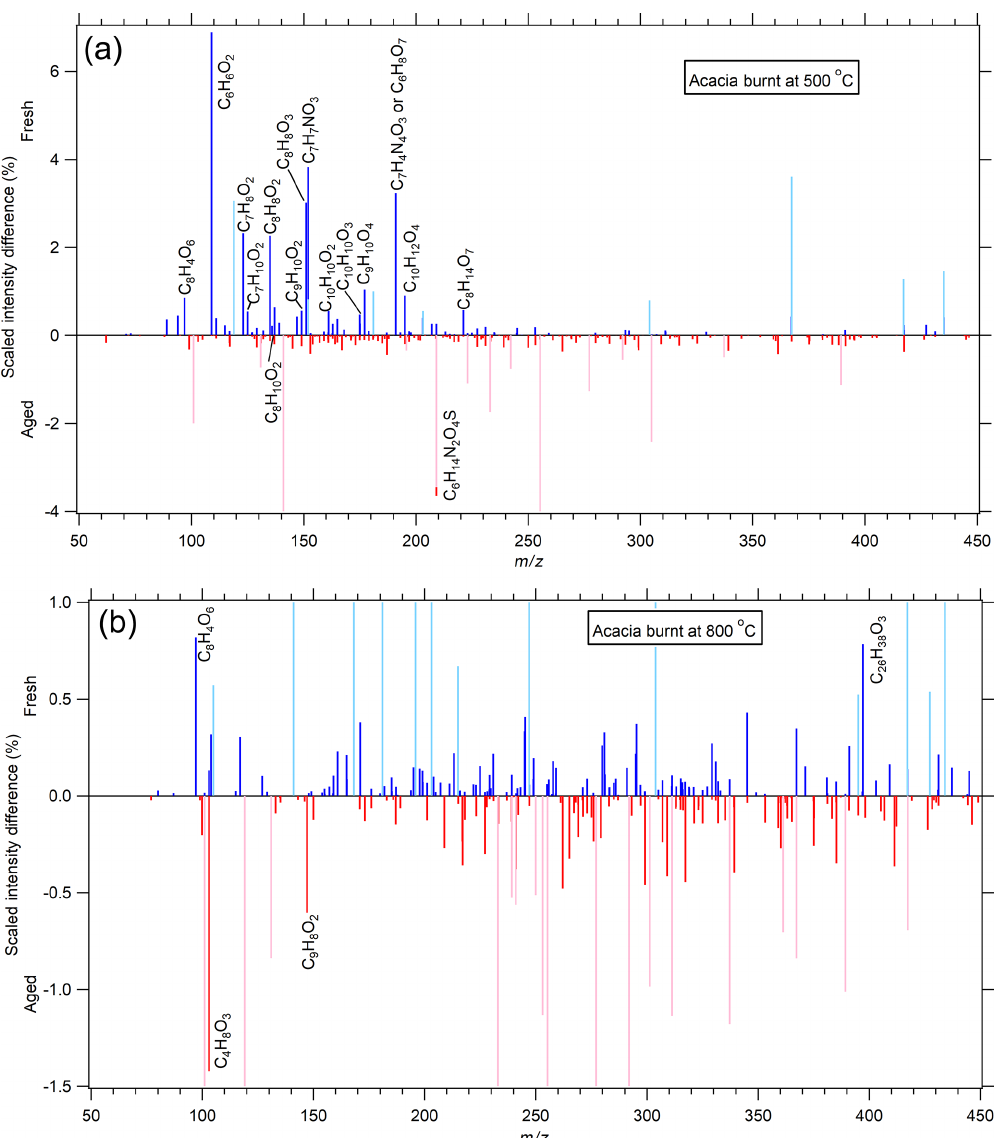
Figure 3. A comparison of acacia-derived BB aerosol combusted at 500 ◦ C (a) and 800 ◦ C (b) under fresh and photochemically aged conditions with VOCs in terms of the scaled intensity difference (see Sect. 2.5). Species more present in the fresh sample have positive values (blue lines), while those more present in the aged sample have negative values (red lines) (i.e., species with positive values have been removed because of the aging process, while those with negative values are either produced or represent a greater relative contribution to the aged sample). Peaks in lighter colors were present in the XCMS analysis but were found to be present in significant amounts in the blank sample. Many of these peaks that were found in the blank extend past the scale of the plot but were cut off to focus on species associated with BB aerosol. Compounds having an absolute difference greater than 0.5% have been labeled. There is very little change for combustion at 800 ◦ C, while 500 ◦ C shows a net removal of many